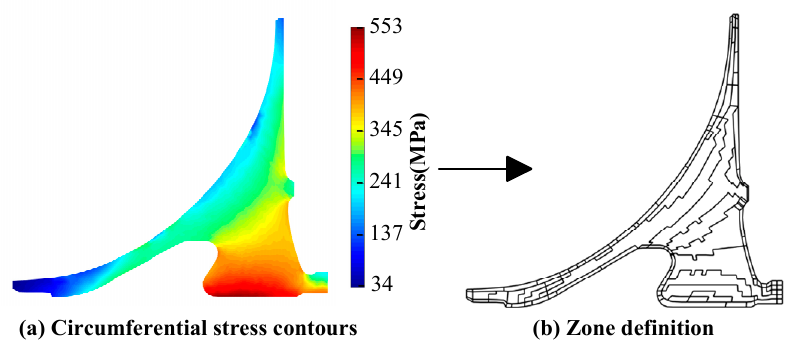
Figure 7. Stress contours and zone